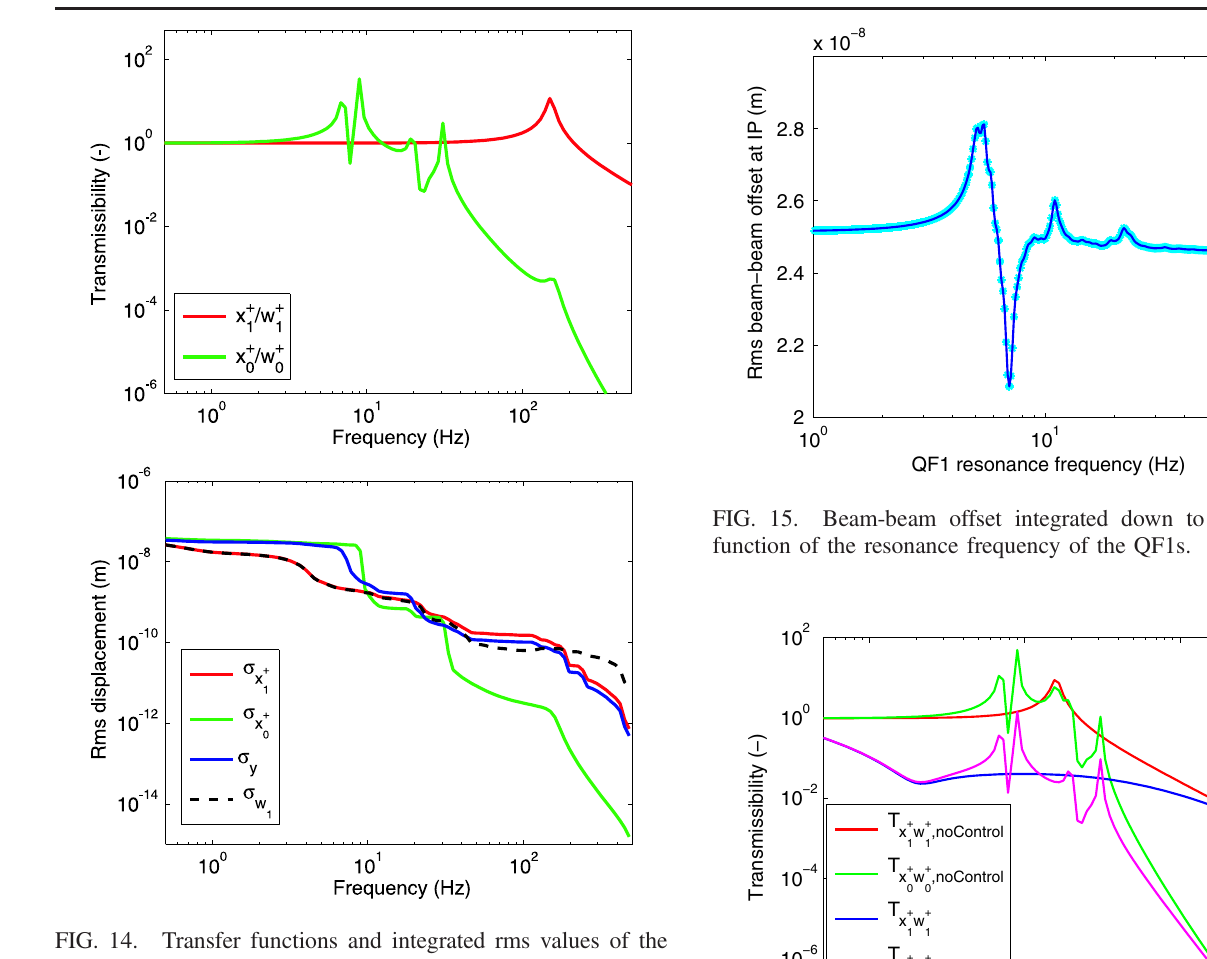
¼ 150 Hz with σ ¼ 0 . 02 N . QF 1 F 2